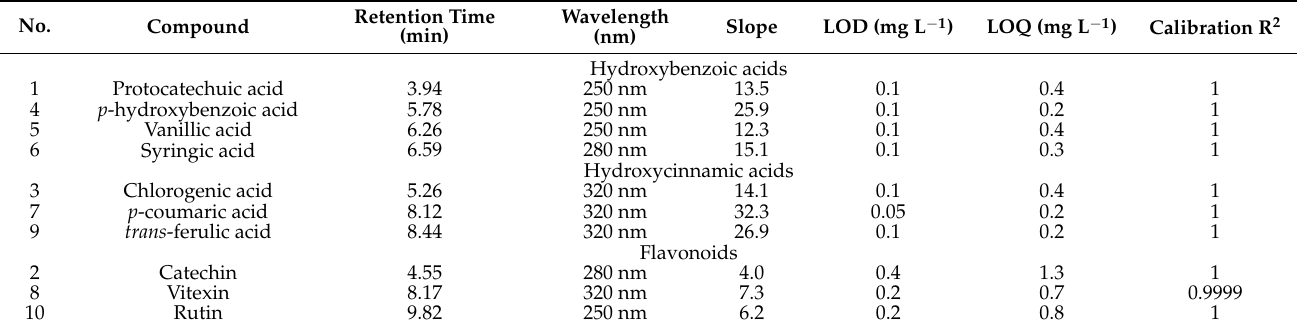
Table 3. Quality-of-analysis parameters for the phenolic standards. All calibrations were performed at concentrations between 1–100 mg L − 1